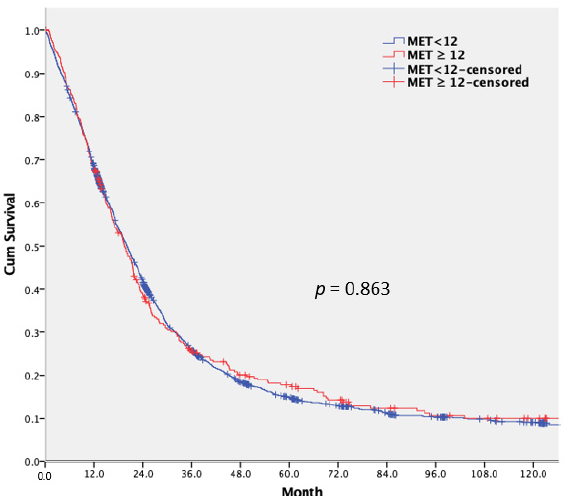
Figure 3. Relation between overall survival and weekly metabolic equivalent of task (MET; p = 0.863). Table 3. Multivariable models from weighted Cox proportional hazard regression for overall sur- vival.